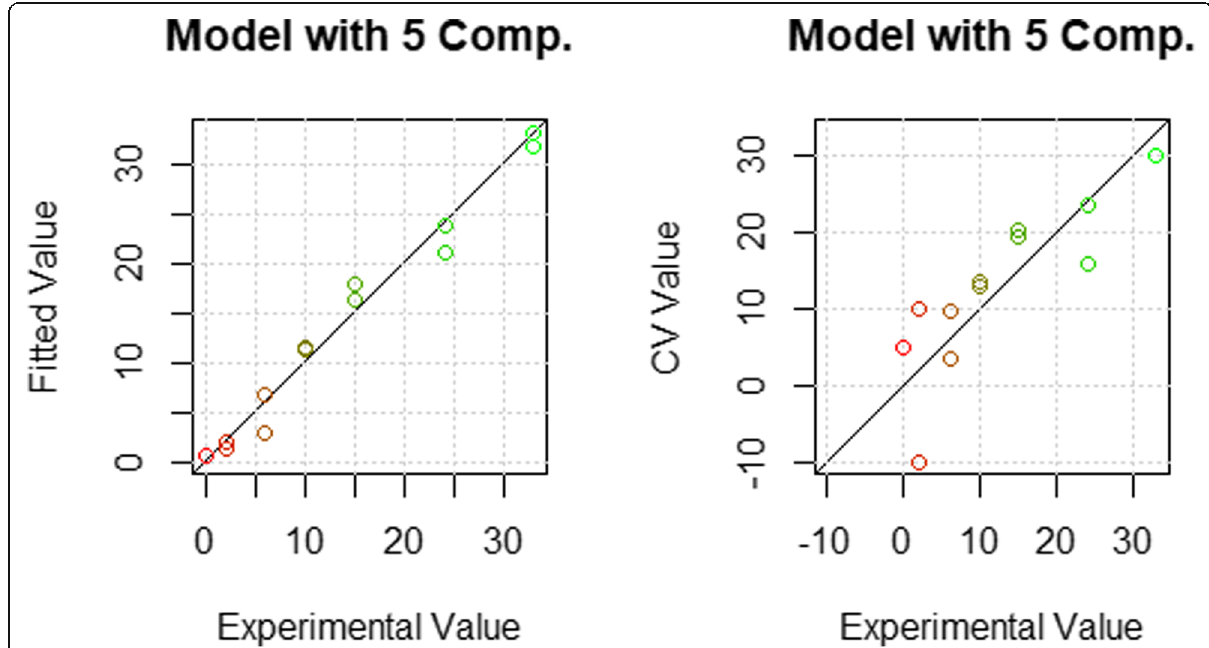
Fig. 5 Software output for the PLS regression model, based on 5 latent variables, for the hardness determination by EBT-CC sensor. The different colours refer to two different experiments at low (red) and high (green) hardness degree. (1) Comparison of the experimental points with the points recalculated from the model; (2) the same comparison but in conditions of cross-validation. This plot assesses the variability of the estimated parameters and its effect on the prediction